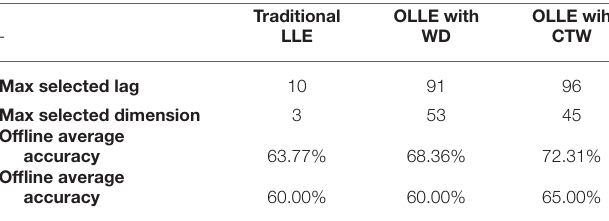
TABLE 2 | The comparative accuracy results of traditional the largest Lyapunov exponent (LLE), optimized LLE (OLLE) using CTW and DW algorithms. -